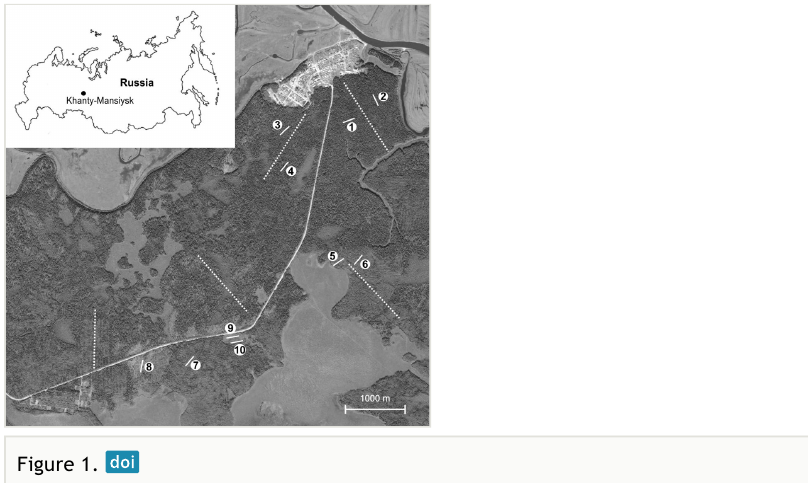
Position of 10 plots (white bars) and walking routes (dotted white lines) on a Landsat satellite image from July 2014 for terrestrial macromycetes observations near Khanty-Mansiysk (Shapsha village showed in upper right